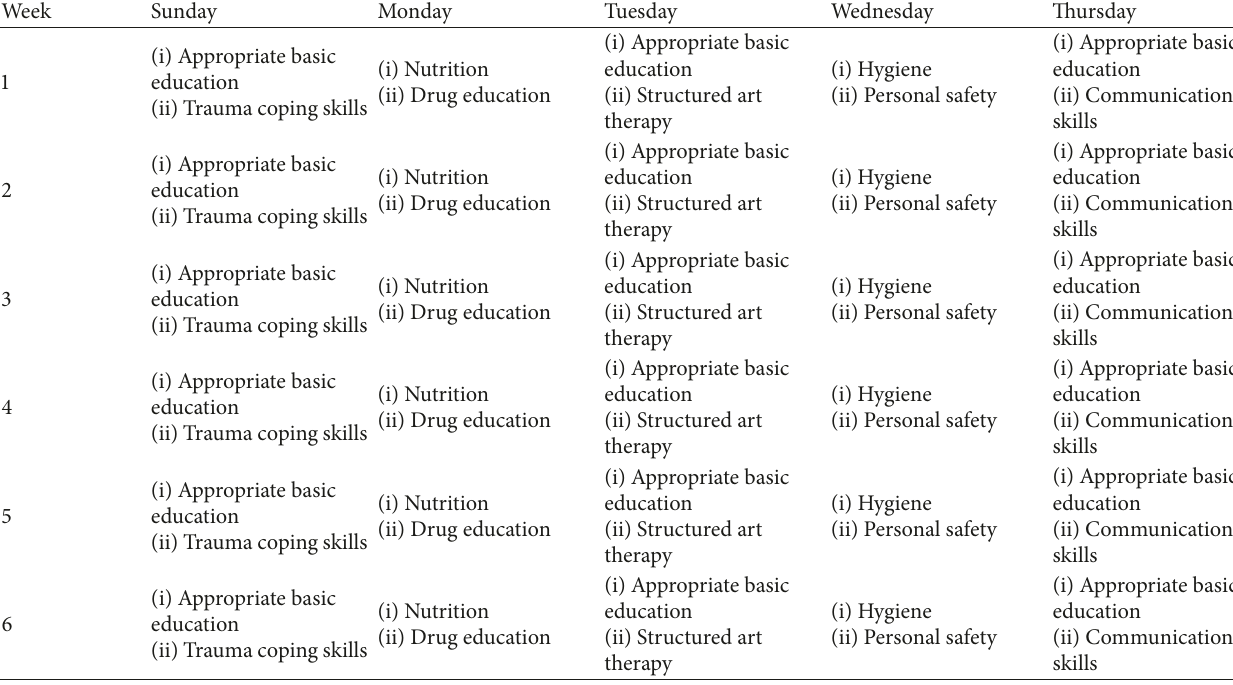
Table 1: Example schedule of intervention components that younger children receive while in residential inpatient treatment for 45